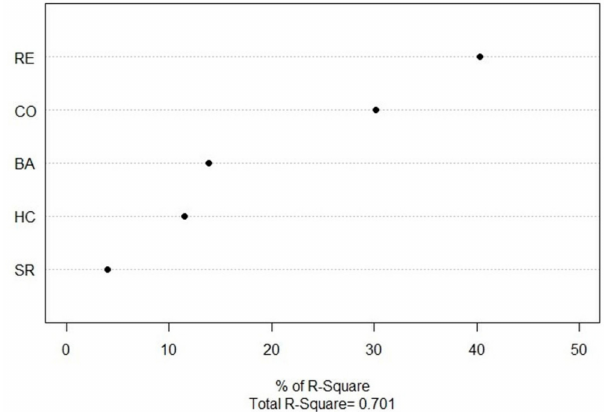
Figure 7. The selection variables by backward elimination are about multiple regression analysis (Table 3). The relative importance of predictor variables is represented by black points. (Note. RE: Rock exposure; CO: Canopy openness, BA: Basal area; HC: Herbaceous cover; SR: Species